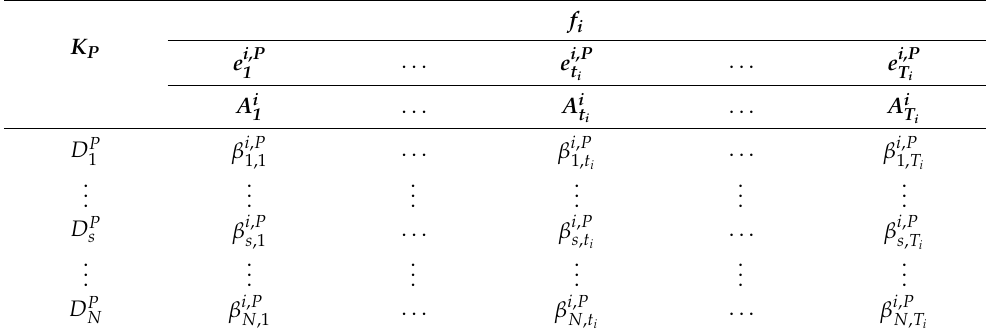
Table 2. The IREM P of the input f i